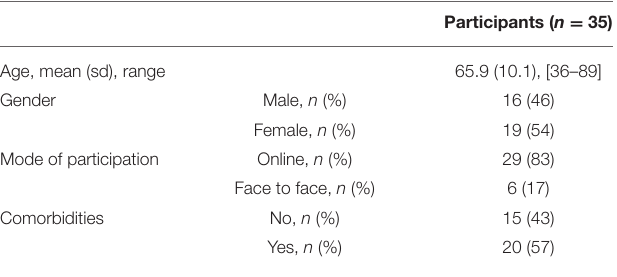
TABLE 1 | Participant